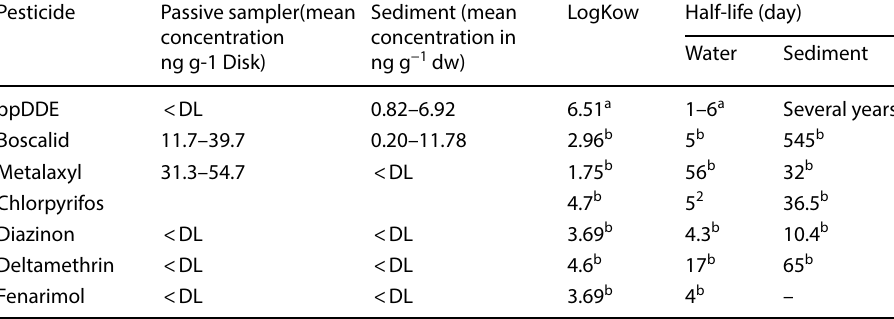
Means of boscalid and p,p´ DDE that do not have the same letter are significantly different ( P < 0.05) among Sites in lake Ziway